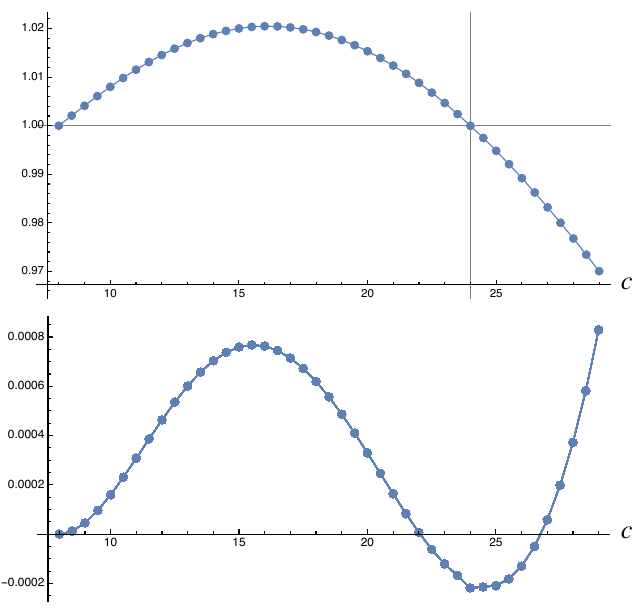
Figure 14. Upper plot shows the upper bound on the boundary entropy g , given by (6.2), coming from the analytic functionals under the assumption h gap ≥ ( c + 8) / 16 . Lower plot shows the difference g ana. − g num. between the analytic upper bound (6.2) and the corresponding bound derived using the standard numerical bootstrap under the assumption h gap ≥ ( c + 8) / 16 at N = 127